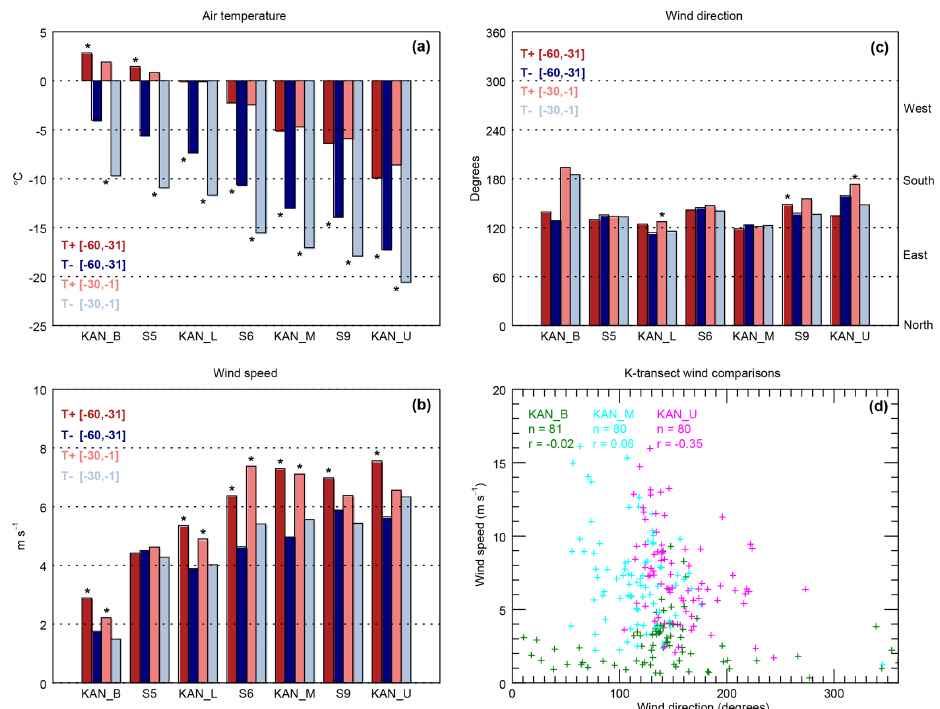
Figure 4. Composites of (a) near-surface air temperature, (b) wind speed, and (c) wind direction for the T + and T − events at KAN_B preceding the Baffin Bay date of sea ice advance (DOA), 2011–2015. Significant differences ( p ≤ 0 . 05) between T + and T − composites over similar time windows are shown by an asterisk ( ∗ ) between the bars. Panel (d) shows daily mean wind speed as a function of direction for select, roughly equidistant K-transect PROMICE stations.